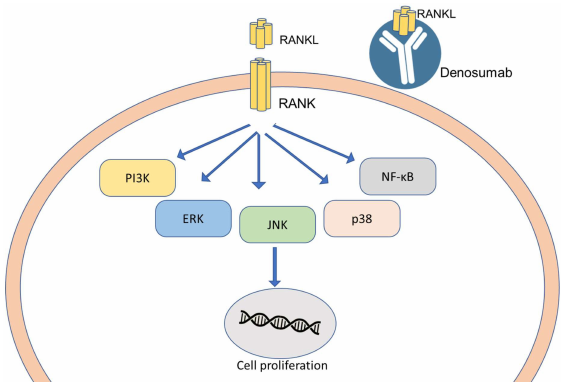
Figure 4. Schematic representation of the RANK / RANKL pathway. Pathways activated by RANK-RANKL signaling and downstream targets. ERK = extracellular signal-related